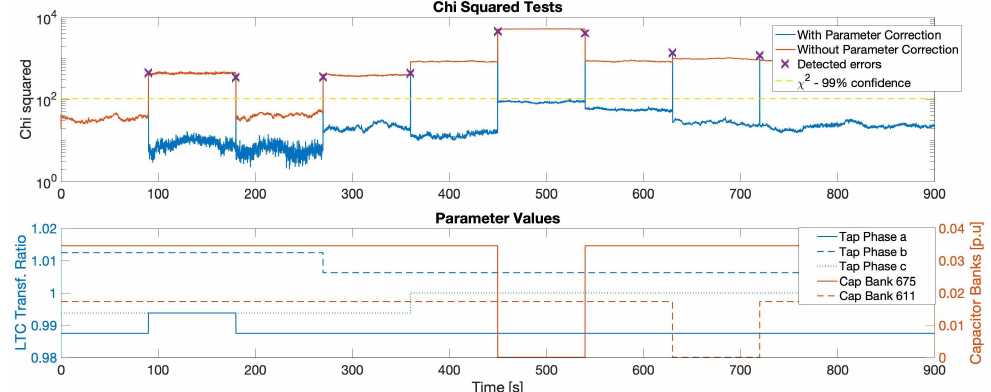
Figure 7. Chi-square value ( top ) and turns-ratio of LTC and value of capacitor banks ( bottom ). The power flows from the substation bus into the feeder, shown in Figure 8, illustrate that changes in the position of the taps created a deviation in both real and reactive power flows, while the effect of the capacitor bank connection can only be noticed clearly in the reactive power plot. The large increases in reactive power reaction at t = 450 s and t = 630 s and the subsequent decreases at t = 540 s and t = 720 s are used to correctly identify the operation of the capacitor banks. Distinguishing between the capacitor banks at bus 675 vs. bus 611 is done by comparing the information based on µ PMU measurements at but 671. If a large change is seen on all three phases, the capacitor bank at bus 675 has switched. If a smaller, but significant change is seen only on phase c, the capacitor bank at bus 611 has switched. Figure 8 shows the phase c power flows such that all VVC operations are shown.